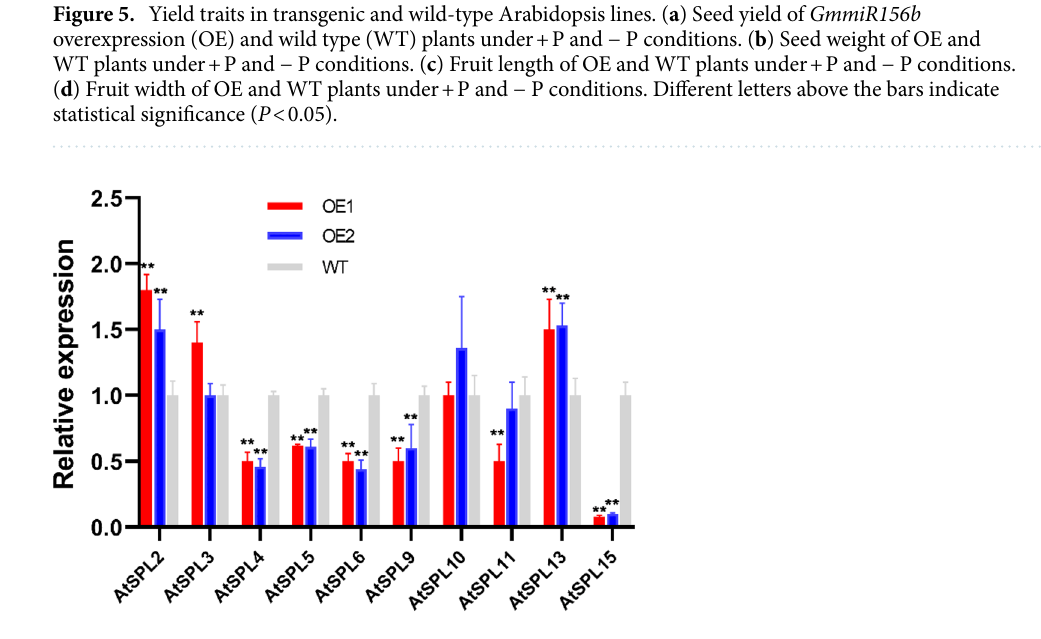
Figure 6. Transcriptional analysis of AtSPLs targeted by GmmiR156b in overexpression lines. Quantitative RT-PCR analysis was performed using RNA extracted from wild-type (WT) and overexpression lines (OE1 and OE2) for putative targets of GmmiR156b (i.e., AtSPL2/3/4/5/6/9/10/11/13/15 ). The relative expression level of AtSPL s in OE lines was normalized to that of the WT. Tublin was used as inner control for gene expression analysis. ** indicates a statistical difference between AtSPLs and Tublin at P <